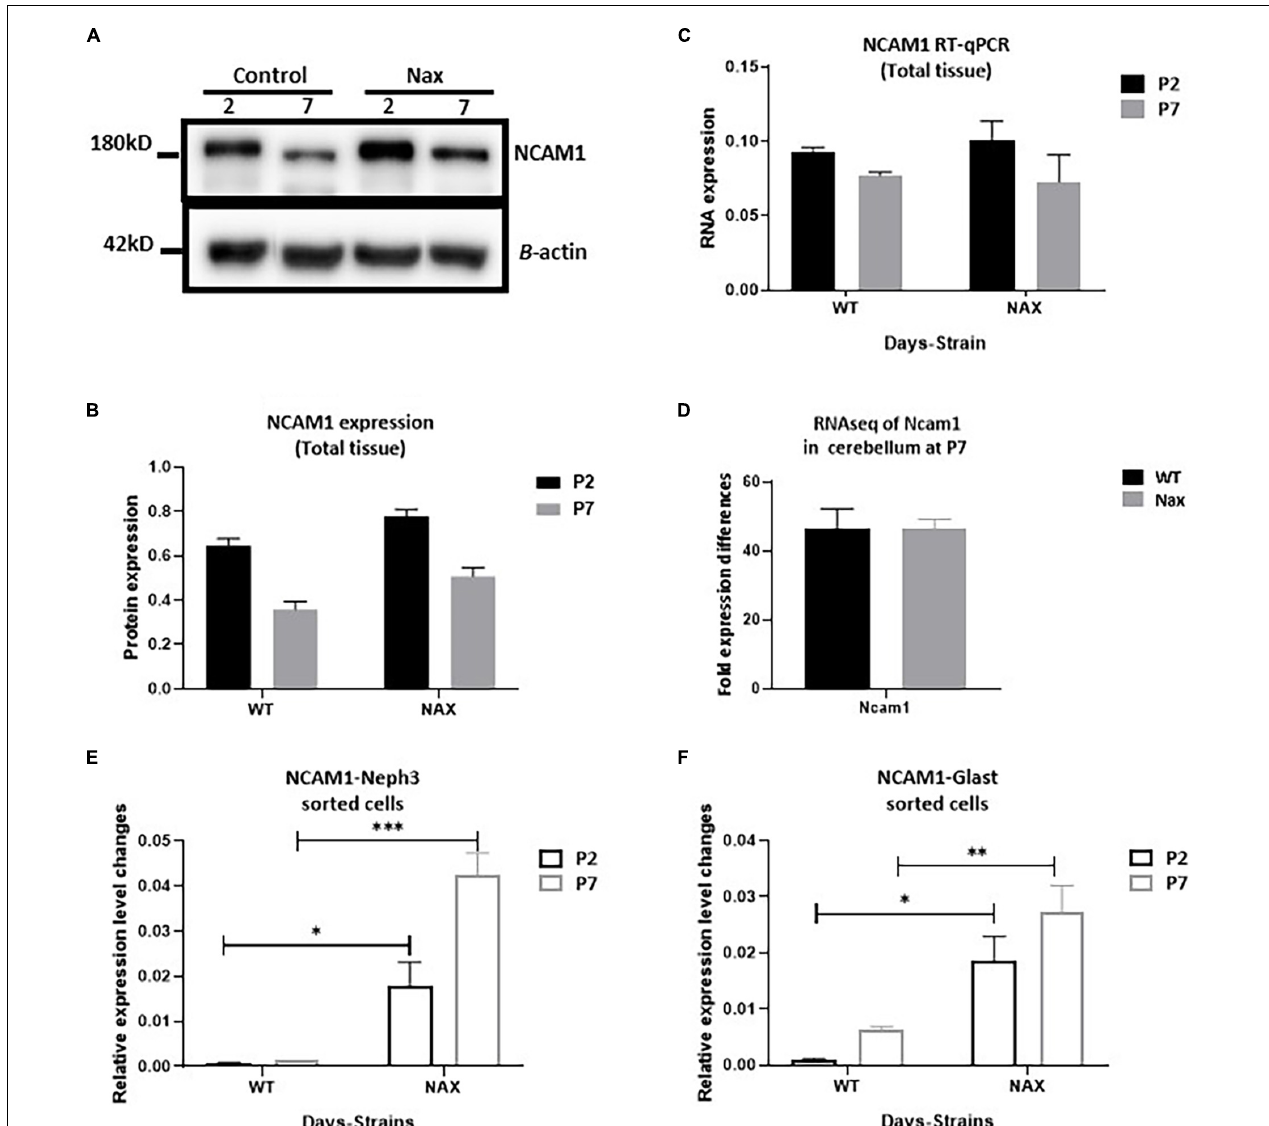
FIGURE 5 | Transcription of NCAM1 in nax PCs and BGCs significantly increases. (A–C) NCAM1 expression and transcription in the whole cerebellum tissue is measured by Western blot (A,B) and RT-qPCR (C) at P2 and P7. The NCAM1 protein and mRNA values does not show significant difference between wt and nax cerebellum (blot image of P2, P5, and P7 in Supplementary Figure 1 ). (D) RNAseq analysis of nax and wt cerebellum at P5/P7 to confirm total cerebellum RT-qPCR results; Ncam1 transcription shows the same value in both nax and wt cerebellum. (E,F) RT-qPCR of RNA collected from isolated PCs and BGCs from nax and wt cerebellum at P2 and P7. The mRNA value of NCAM1 in nax cerebellum from both P2 and P7 is significantly higher than the wt littermate. This experiment was repeated over three different litters for each postnatal day in nax and wt littermate ( wt ; n = 3 and nax ; n = 3). The data in the bar graph are presented as the mean ± SEM, and statistical analysis was performed using multiple comparison ANOVA (* p < 0.05, ** p < 0.01, *** p < 0.001). PCs, Purkinje cells; BGCs, Bergman glia cells. Scale bars: A = 50 µ m (applies to panels A–D